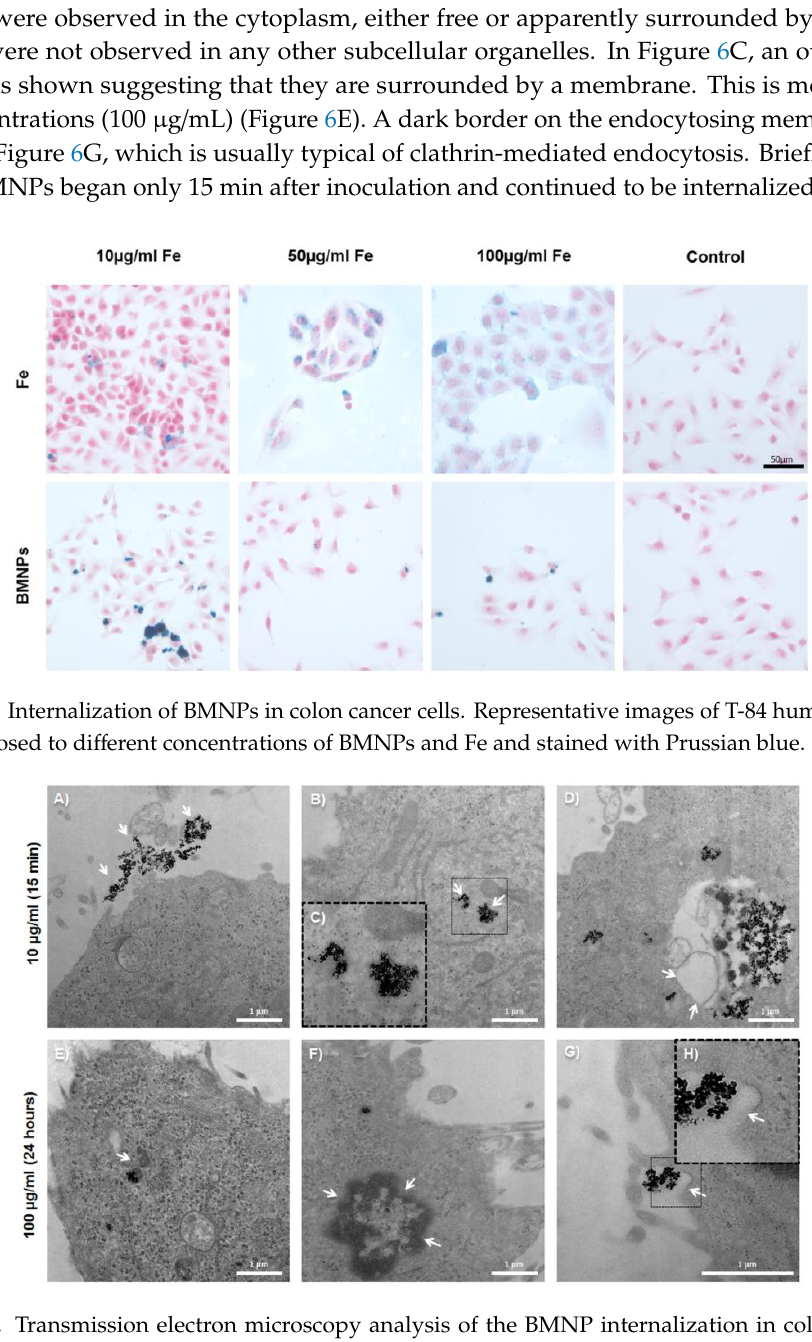
Pharmaceutics 2019 , 11 , x 11 of 19 Figure 4. Cell proliferation assay of colon cell lines treated with BMNP and FeCl 3 . The cell lines HT29 ( A ), SW480 ( B ), HCT15 ( C ), MC38 ( D ), T84 ( E ), and CCD18 ( F ) were exposed to increasing